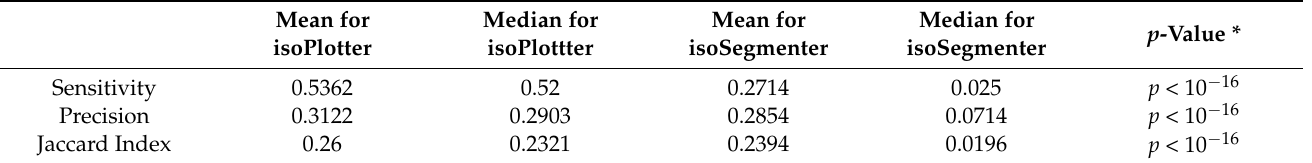
Table 1. Performance metrics of isoPlotter and isoSegmenter on the simulated sequence